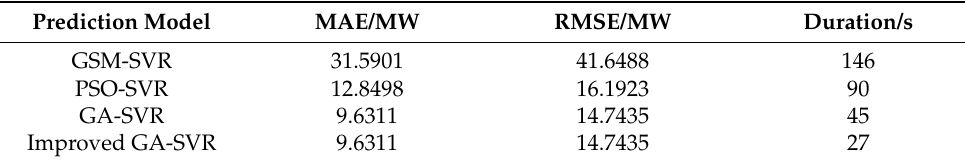
Table 1. Comparison of evaluation index and training time.